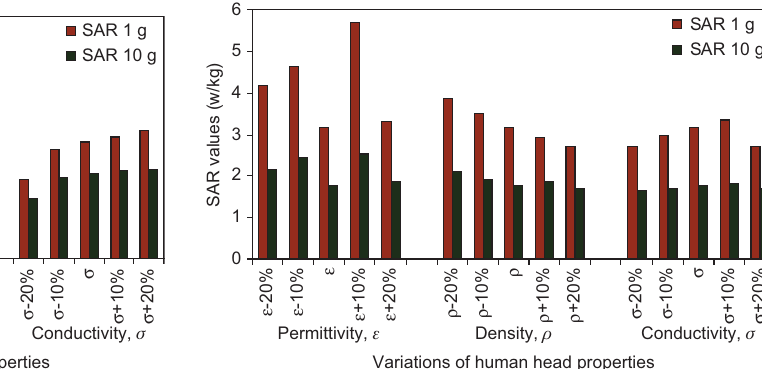
Figure 5 SAR values in human head at 1900 MHz with antenna substrate of